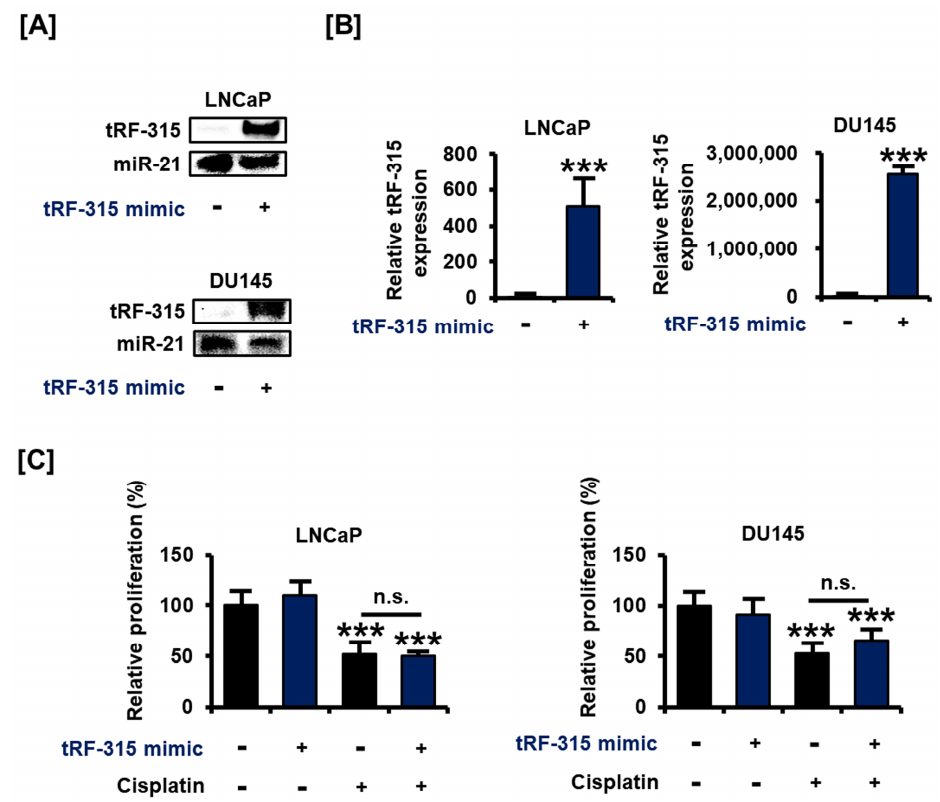
Figure 2. tRF-315 mimic does not affect the proliferation of prostate cancer cells. ( A ) The expression of tRF-315 in response to the transfection of the tRF-315 mimic (20 nM) for 6 h in LNCaP and DU145 cells was detected by blotting. ( B ) Quantita- tive PCR was performed to quantify the expression of tRF-315 in response to transfection of tRF-315 mimic (20 nM) for 6 h in LNCaP and DU145 cells. The expression of tRF-315 was quantified using the 2 −ΔΔCT method based on standard curves and cycle threshold (C T ) values. ( C ) The change in the proliferation of LNCaP and DU145 cells following transfection with the tRF-315 mimic (20 nM) for 6 h and cisplatin (20 μM) treatment for 24 h was confirmed by BrdU analysis. The value of the control group was expressed as 100%. The data represent three independent experiments. The asterisks indicate sig- nificant differences between the treated cells and control cells (*** p < 0.001). The symbol ‘n.s.’ indicates that there is no significance between the two